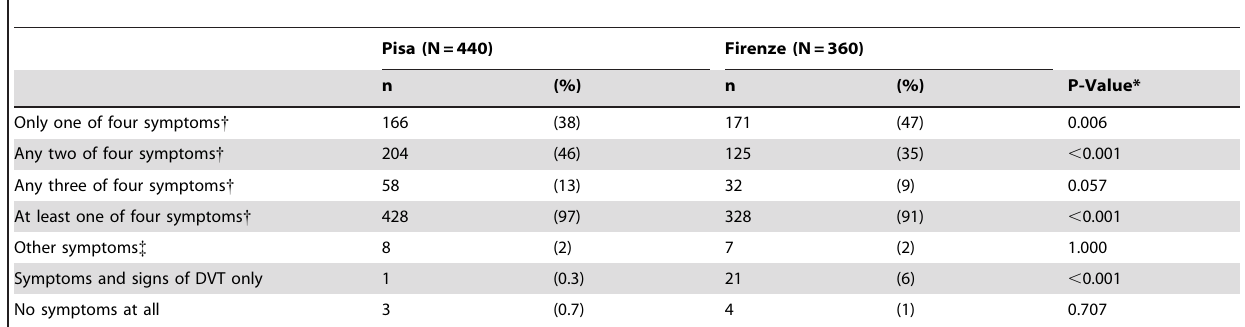
Table 6. Combination of clinical symptoms and signs in 800 patients with pulmonary embolism (Pisa versus Firenze).